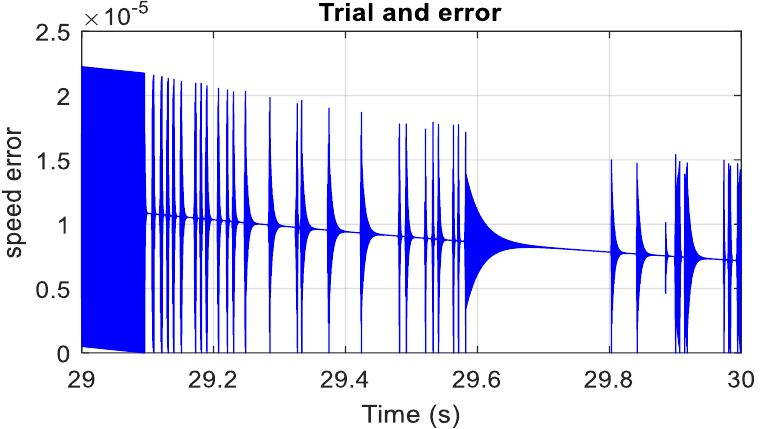
Figure 17. BEV absolute speed error based on trial and error.